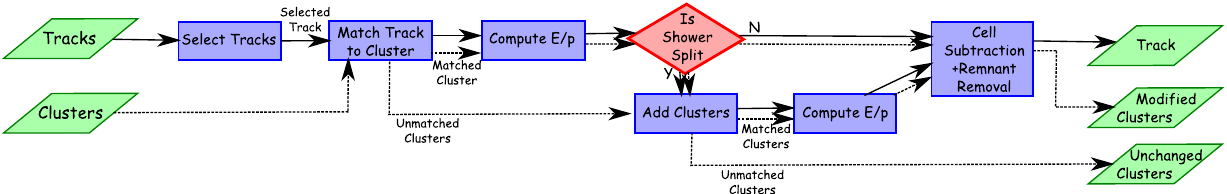
Fig. 2 A flow chart of how the particle flow algorithm proceeds, start- ing with track selection and continuing until the energy associated with the selected tracks has been removed from the calorimeter. At the end,